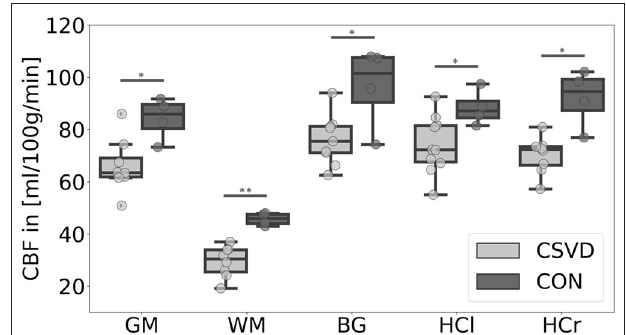
FIGURE 1 | Mean cerebral blood flow (CBF) differences between patients with cerebral small vessel disease (CSVD) and controls (CON) for several regions-of-interest. Significant group differences ( p < 0.05) of mean gray matter (GM), basal ganglia (BG), left hippocampus (HCl), and right hippocampus (HCr) CBF are marked with *; highly significant group difference ( p < 0.01) of mean white matter (WM) CBF is marked with ** ; outliers are not included.